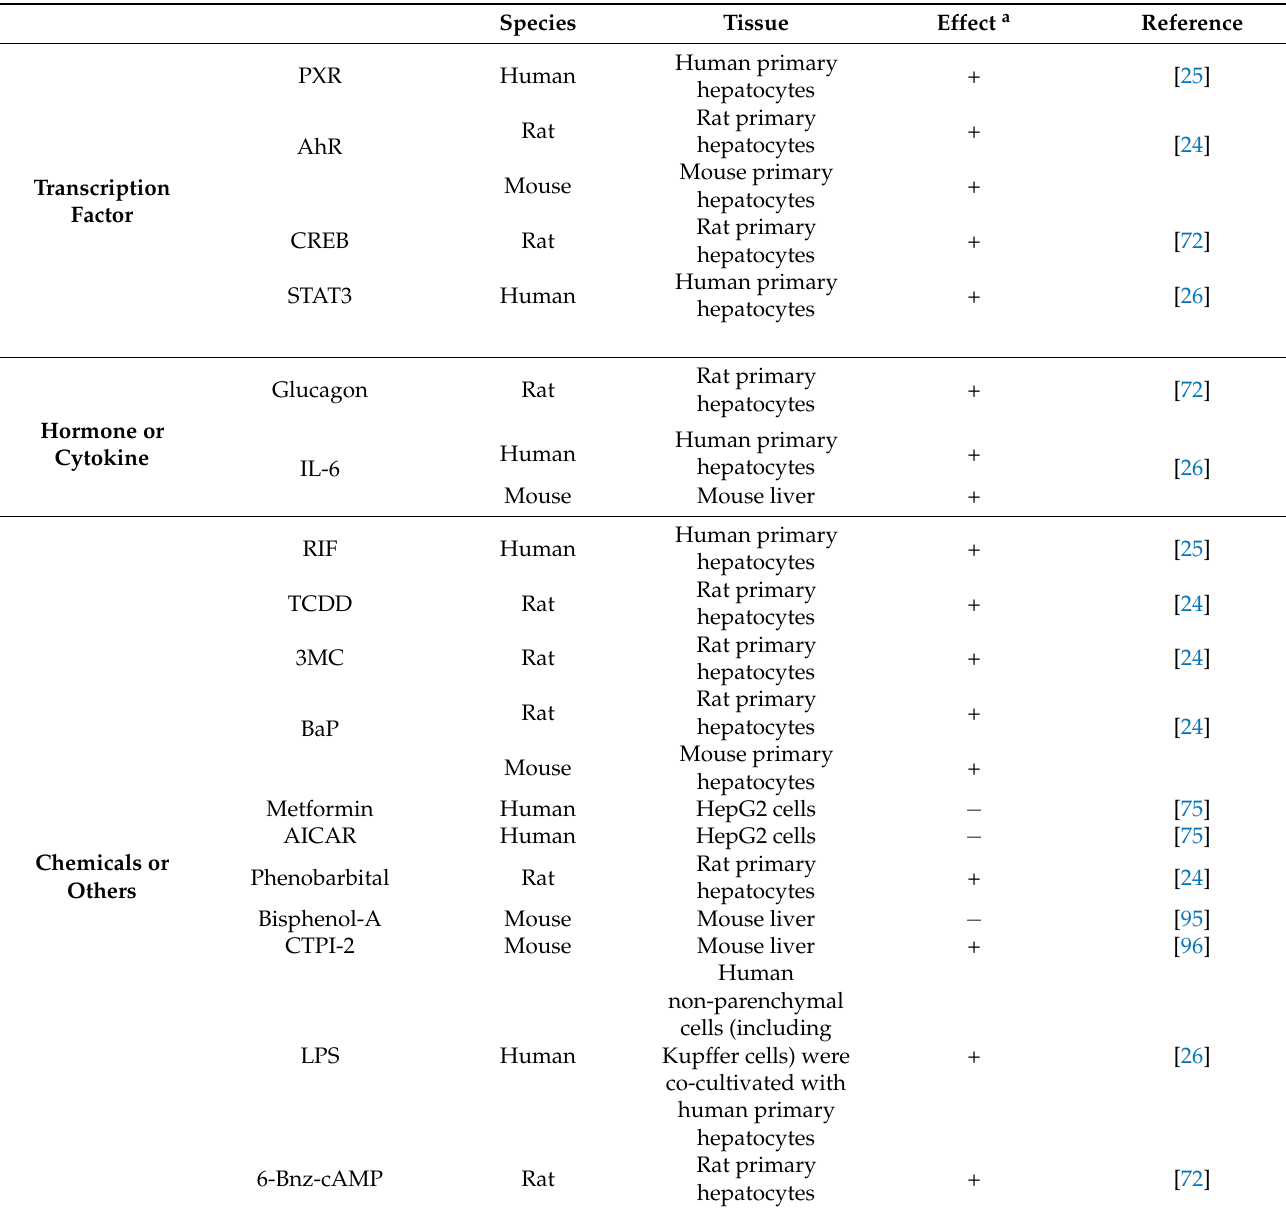
Table 2. Transcription factors or xenobiotic chemicals that regulate SLC13A5 gene